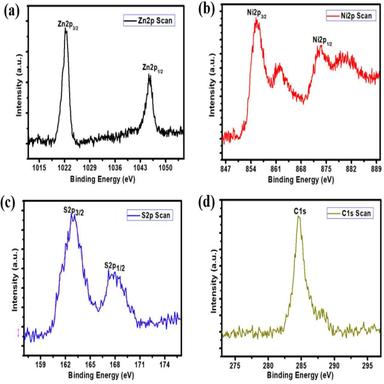
High-resolution scan of the (a) Zn2p, (b) Ni2p, (c) S2p and (d) C1s peaks in ZnO/NiS/CNT composite.